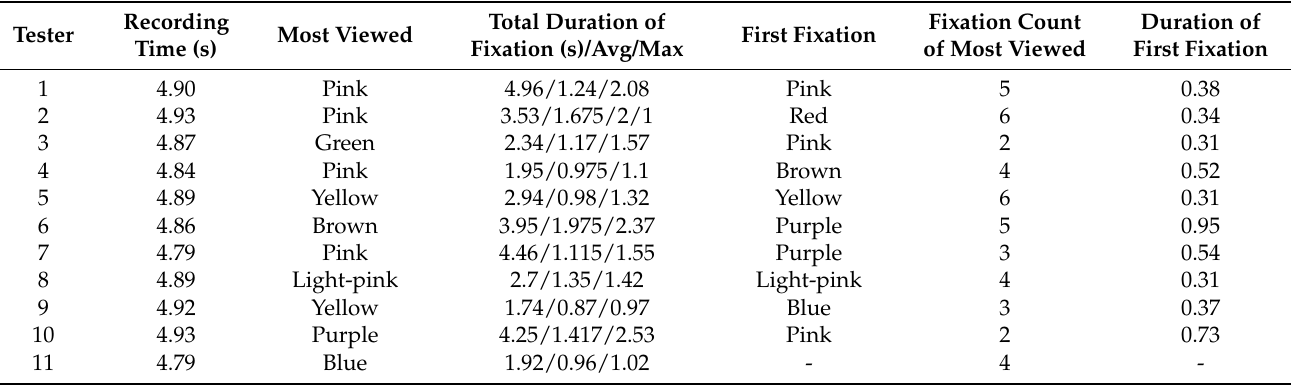
Table 5. Average gaze data for gaze color by subject.